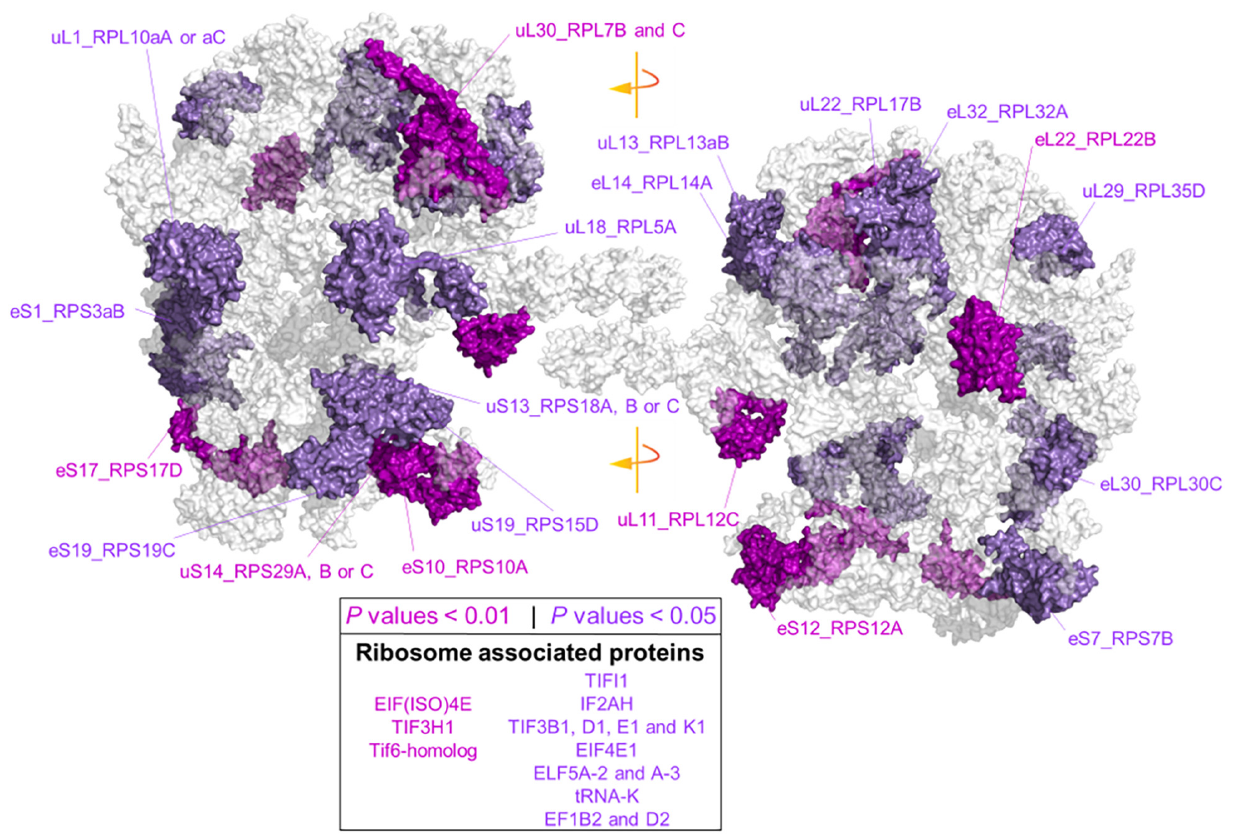
FIGURE 6 | Status of the translational machinery in Hordeum vulgare roots after a shift to 4 ◦ C during 5 days of germination. See also Supplementary Table 7 and Table 2 . Ribosome proteins (RPs) and ribosome-associated proteins (RAPs) were annotated by aligning amino acid sequences from LC-MS/MS barley annotations to the reviewed Arabidopsis thaliana proteome (Swiss-Prot, UniProt). The global alignment was performed in R using following the GitHub repository Align2FASTAs (https://github.com/MSeidelFed/Align2FASTAs). Only alignments with a minimum matching score of 10 were further analyzed. Changes in protein abundances across treatments were tested as detailed in Figure 4 . RPs and RAPs with significantly increased abundances at P values < 0.05 (dark magenta) or < 0.01 (purple) during the cold treatment in roots (i.e., interaction P values < 0.05 of Factor1tip:Factor2cold) were mapped into a 2D rendering of a 3D Cryo-EM model of the